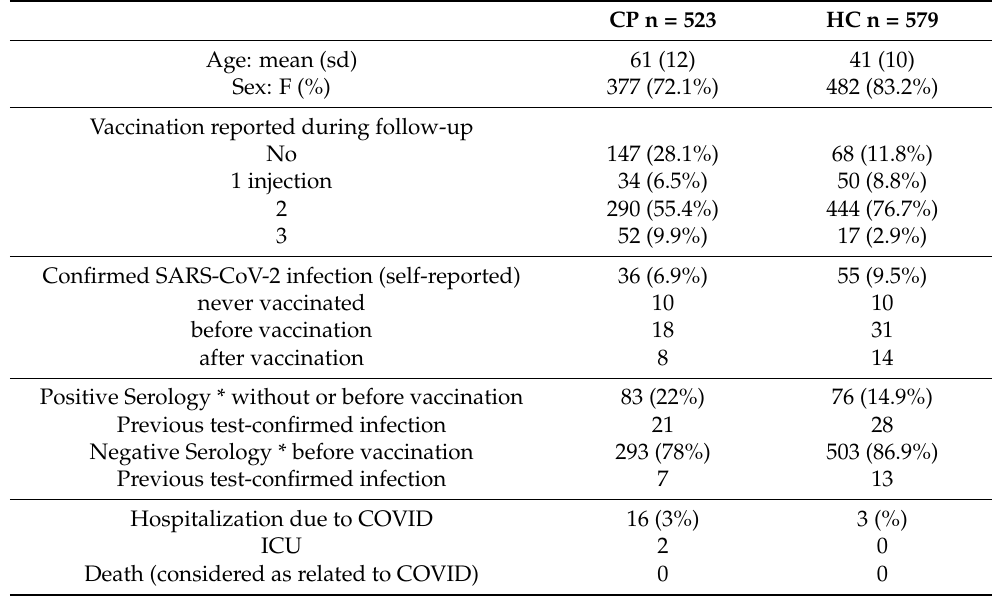
Table 1. Participant characteristics. CP: cancer patients; HCW: health care workers; F: female; ICU: intensive care